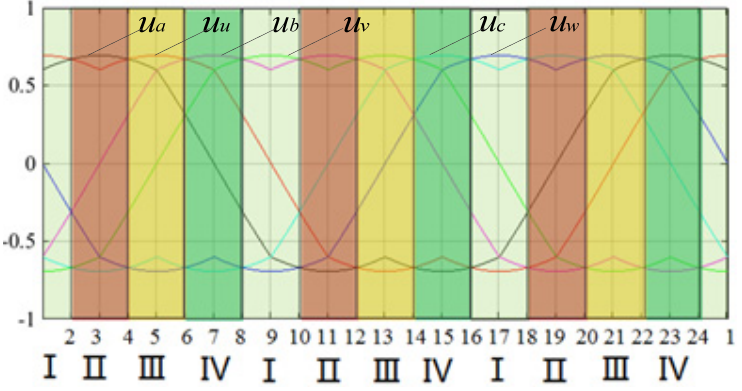
Figure 3. Region division in a fundamental period for the DZICMV.